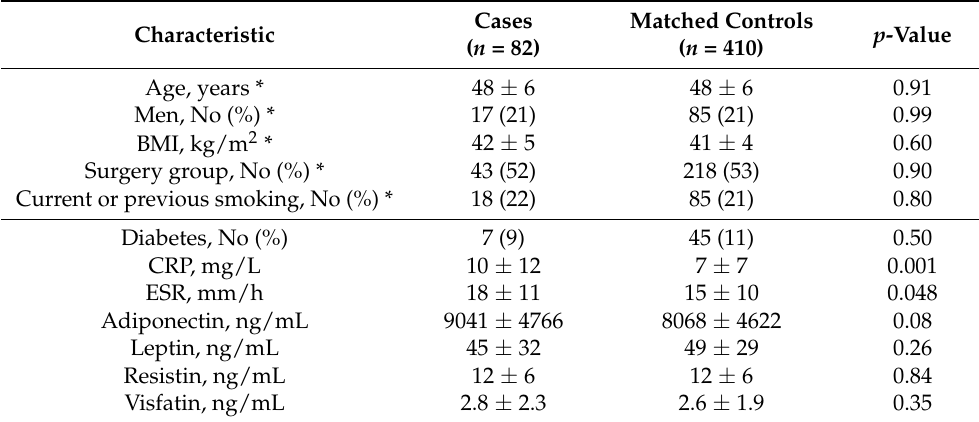
Table 1. Baseline characteristics of the nested case-control cohort from the SOS study. Characteristic